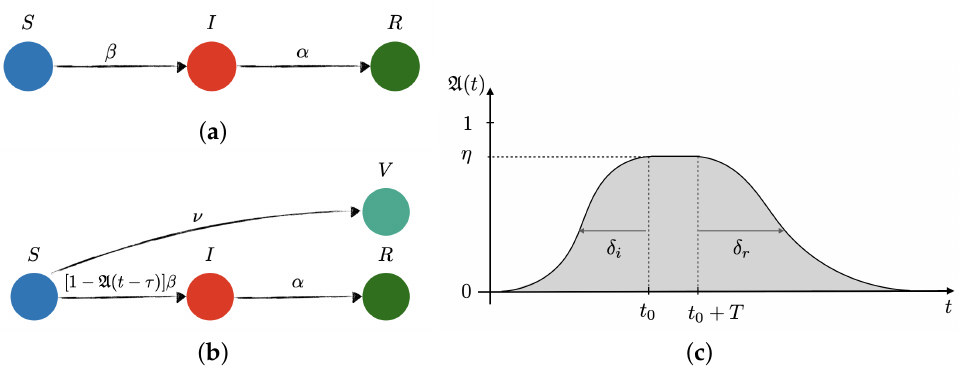
Figure 1. Sketch of transitions in the ( a ) free and ( b ) controlled SIR network models of disease transmission, and ( c ) model of the preventive social response, A ( t ) . S , I , R and V stand for susceptible, infected, recovered, and vaccinated, respectively. Additionally, β , α and ν are the infection, recovery, and vaccination rates, respectively. In the controlled SIR model, the infection rate is reduced by the factor ( 1 − A ( t − τ )) , which depends on the incubation time period, τ , the effectiveness of the social response, η ∈ [ 0,1 ] , the time when the awareness reaches its peak, t 0 , the time extension of the maximum level of alert, T , and the characteristic times for reaching maximum awareness, so-called social inertia, δ i , and the relaxation time after lifting restrictions, δ r ,